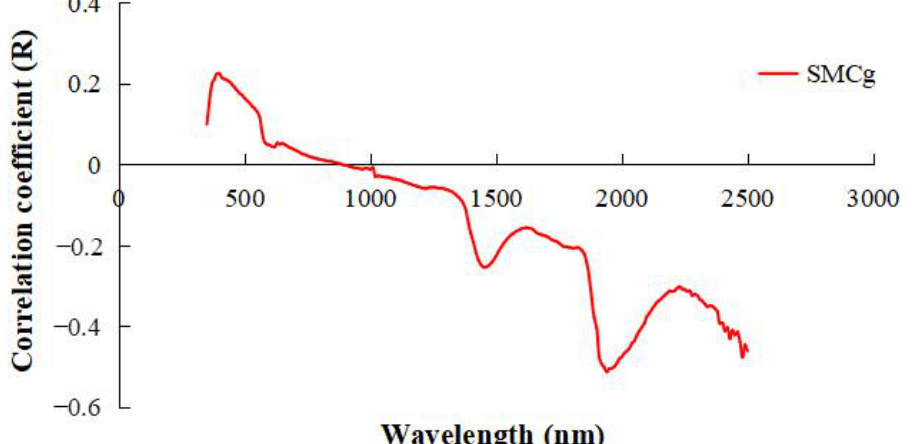
Figure 5. Correlation coefficients between SMC g and its reflectance.